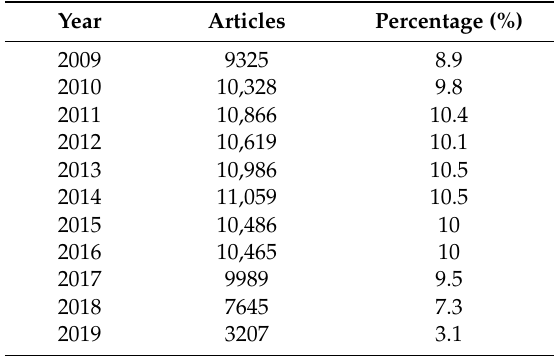
Table 1. Yearly percentage of the articles, 2009 to